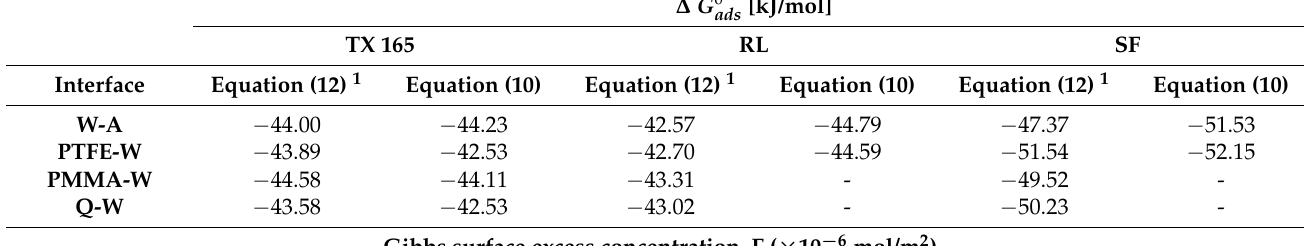
Table 3. The values of the standard Gibbs free energy of the adsorption ∆ ( G 0 concentration (maximal— Γ max and limiting— Γ water-air (W-A), PTFE-water (PTFE-W), PMMA-water (PMMA-W) and quartz-water (Q-W)